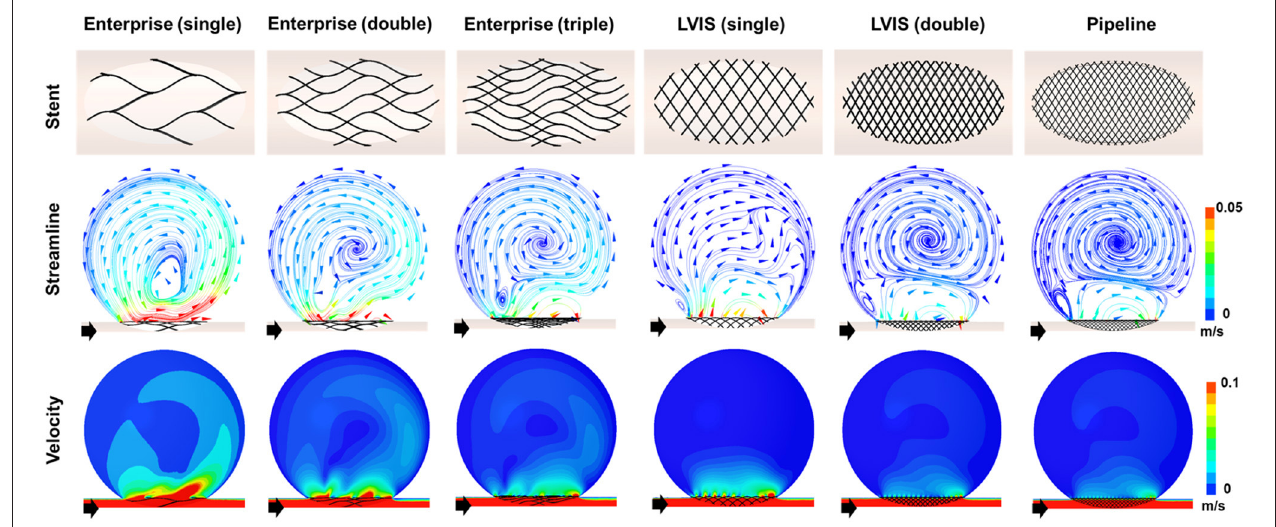
FIGURE 4 | Visualization of the hemodynamic modifications induced by overlapping the stents. The stent configurations deployed in the idealized aneurysm model and the streamlines and velocity contours calculated using CFD analysis are displayed. The black arrows indicate the flow direction. The overlapped Enterprise stents decreased the volume of the inflow jet by disrupting the jet flow, but they did not change the direction of the intra-aneurysmal jet flow even when three stents were used. In contrast, the single LVIS stent without overlapping changed the direction of the inflow jet. A separation of the hemodynamics of the aneurysmal dome and neck, similar to that observed with the Pipeline device, was observed when the two LVIS stents were overlapped. CFD, computational fluid